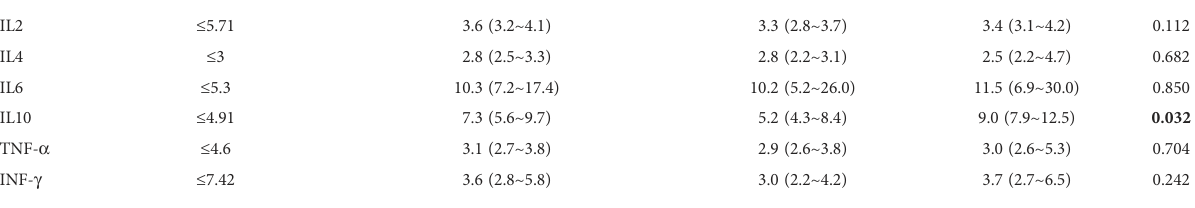
TABLE 6 Cytokine pro fi les